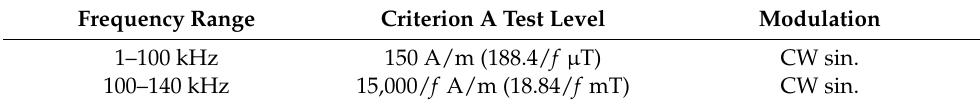
Table 6. Immunity to magnetic field between 1 kHz and 140 kHz for circulatory support